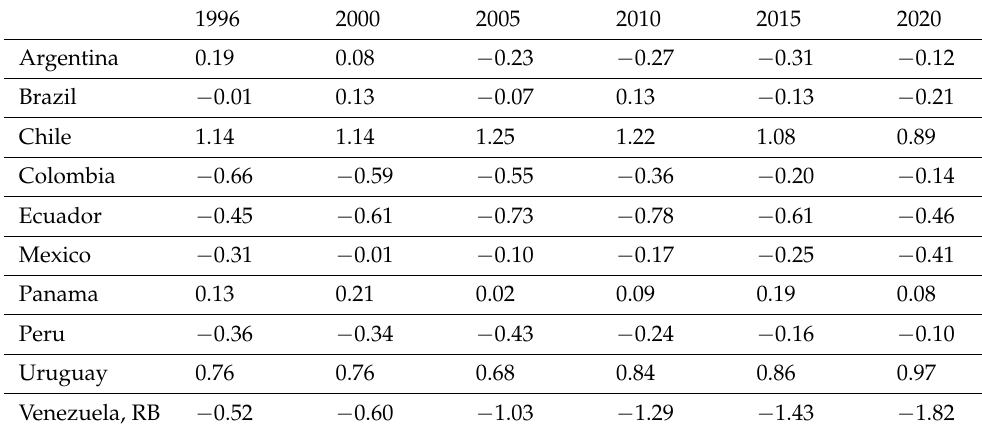
Figure 2. The moderating effects of host country governance on the CD-performance relationship. Table 2. Average for the six WGI variables ranging from 1996 to